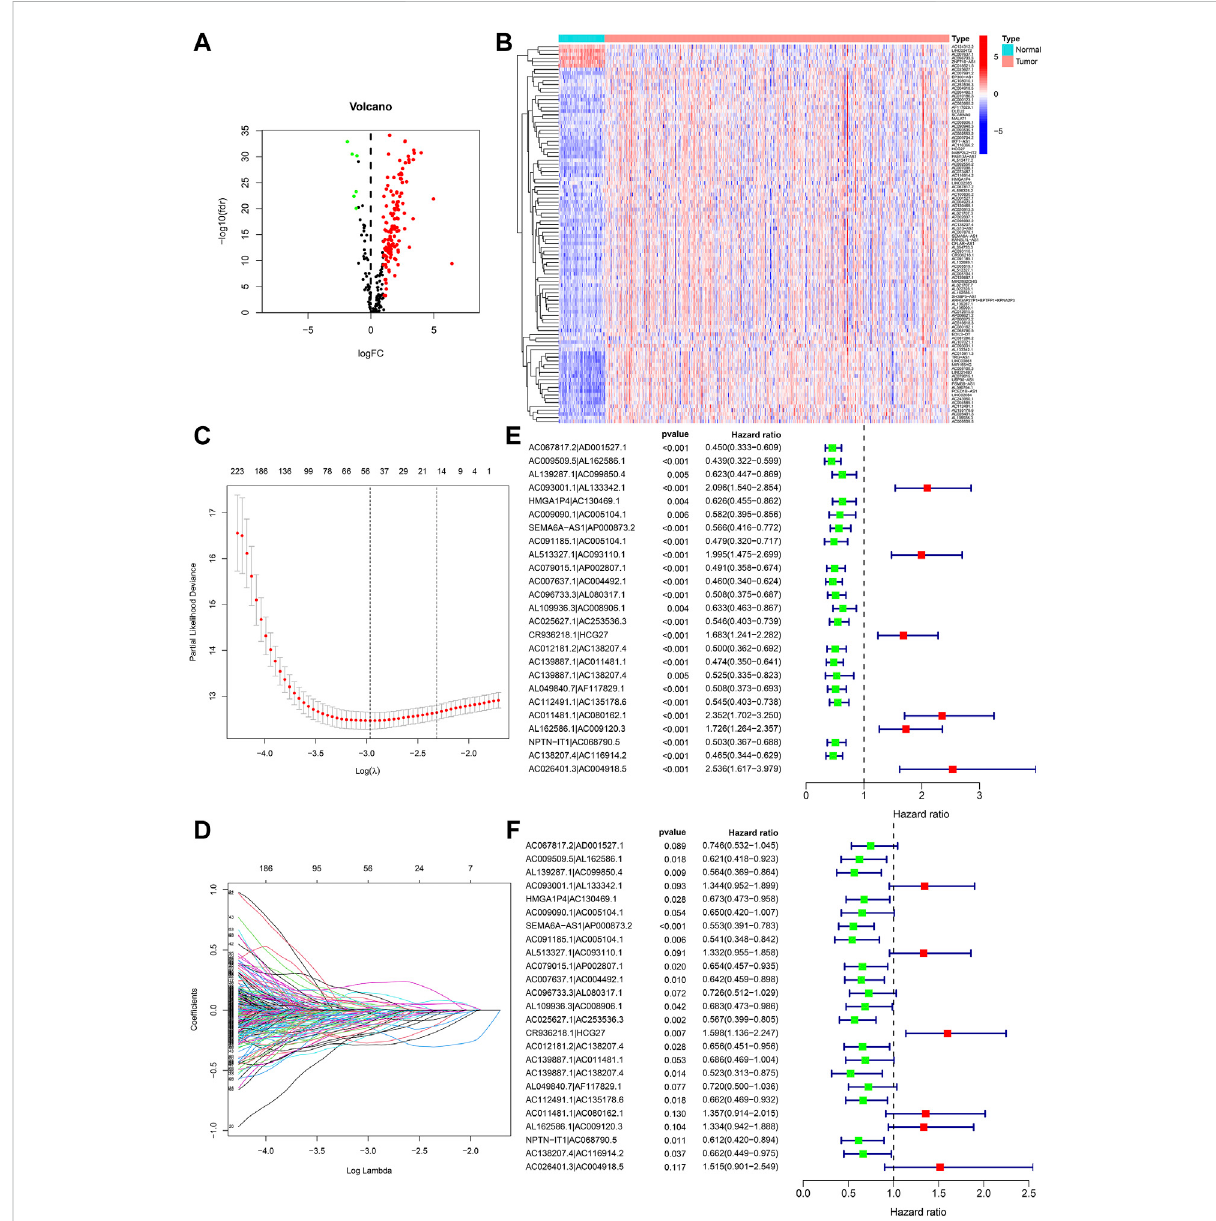
FIGURE 2 Development of nrlncRNA pairs prognostic signature. (A) Heat maps of 136 DEnrlncRNAs. (B) Volcano map of 136 DEnrlncRNAs. (C) Establishment of prognostic DEnrlncRNAs LASSO regression. (D) Distribution of LASSO coef fi cients for 50 DEnrlncRNA pairs. (E) Univariate Cox hazard analyses were conducted for 25 DEnrlncRNA pairs. (F) Multivariate Cox hazard analyses were conducted for 25 DEnrlncRNA